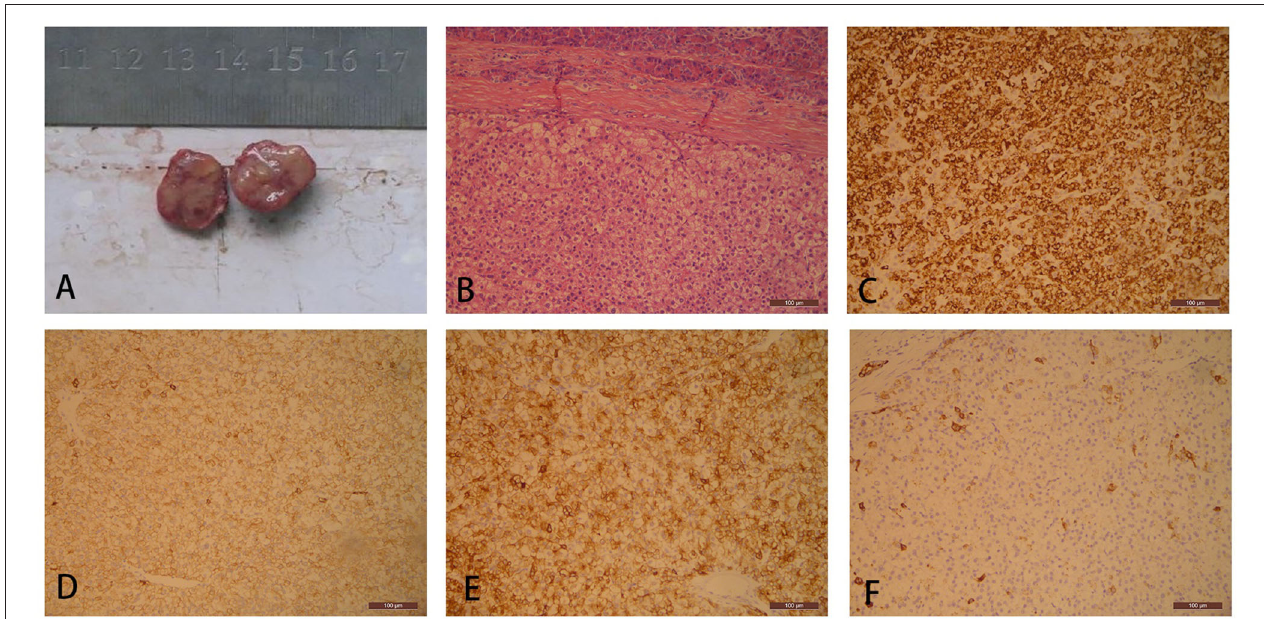
FIGURE 2 | Gross specimen of a pancreatic tumor consists of a well-demarcated and solid firm mass with a yellow appearance (A) . Pancreatic tumor cells are separated from normal pancreatic tissue with a prominent fibrous capsule. The tumor cells are polygonal, densely arranged, and abundant eosinophilic granular cytoplasm with partial cellular edema (hematoxylin and eosin, H&E, × 100) (B) . Ectopic hepatocellular carcinoma (HCC) demonstrates simultaneous cytoplasm positive for (C) HepPar1, (D) CK, (E) CK8, and (F)